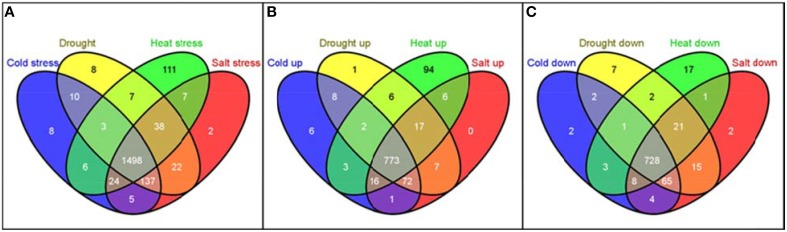
Meta-data analysis of RGA1-regulated genes regulated under various abiotic stresses. The 2270 RGA1-regulated genes (1242 up and 1028 down) were used as input query at Rice DB to generate genes responsive to cold (878 up/810 down), drought (882 up/837 down), heat (913 up/777 down), and salt stress (889 up/841 down) with 1498 genes common to all four stresses and totaling 1886 unique genes. Their Venn selections are depicted as total (A), up-regulated (B) and down-regulated (C) sets, using the online tool Venny (Oliveros, 2007–2015).